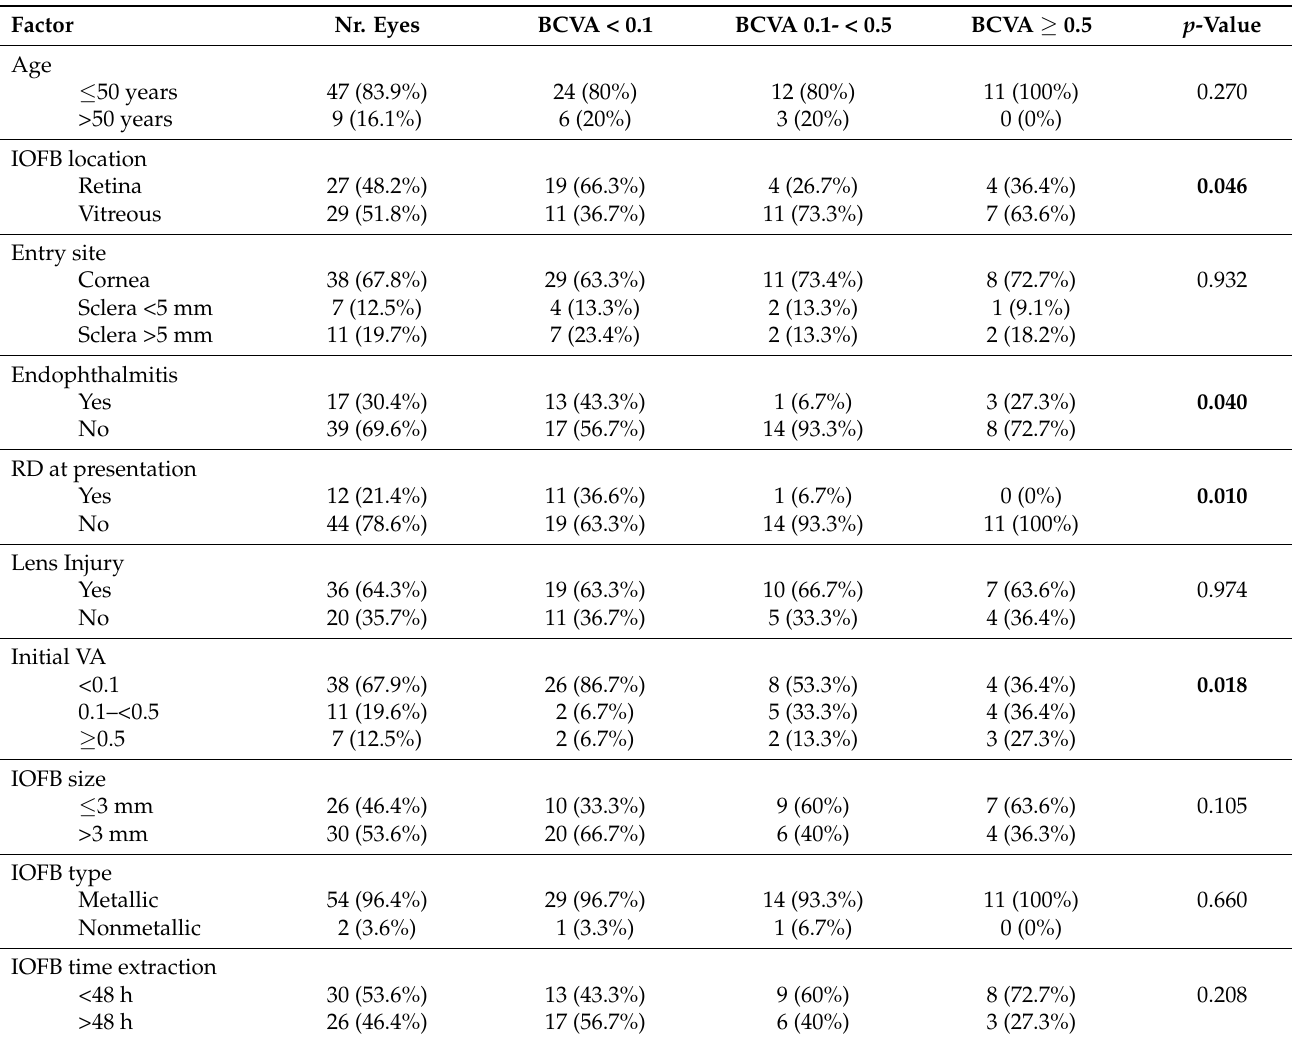
Table 2. Factors influencing final BCVA (univariate analysis of factors affecting the final visual outcome of patients with